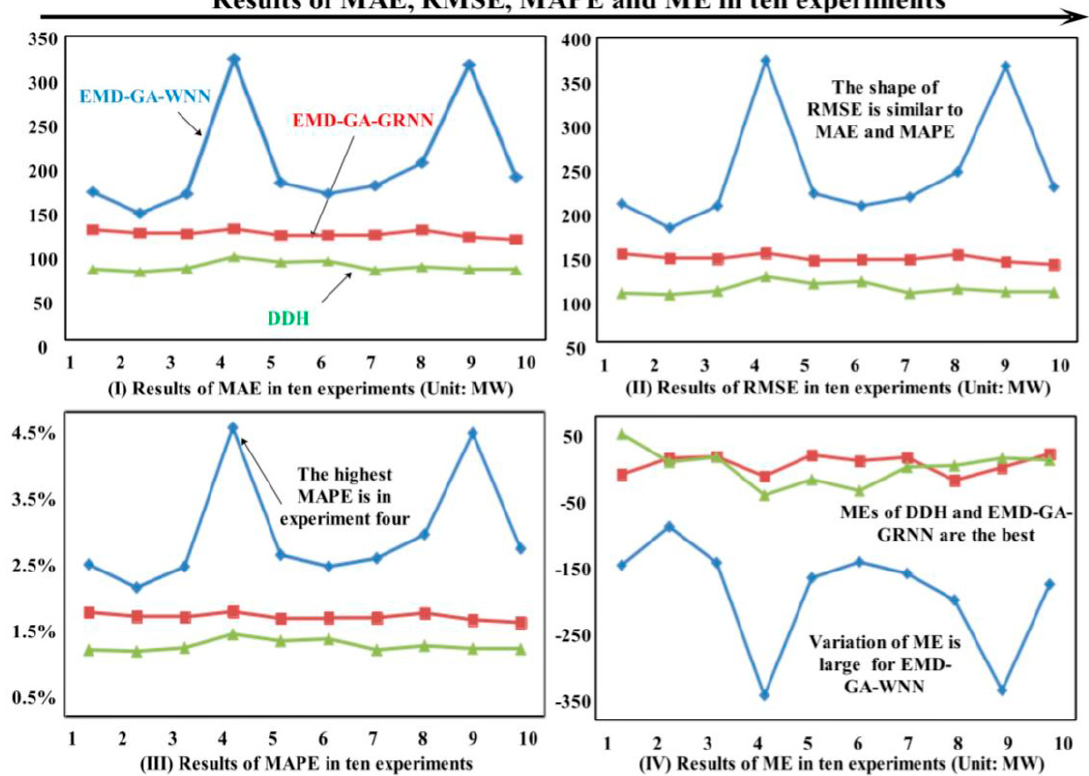
Figure 8. Model evaluation of three forecasting models.